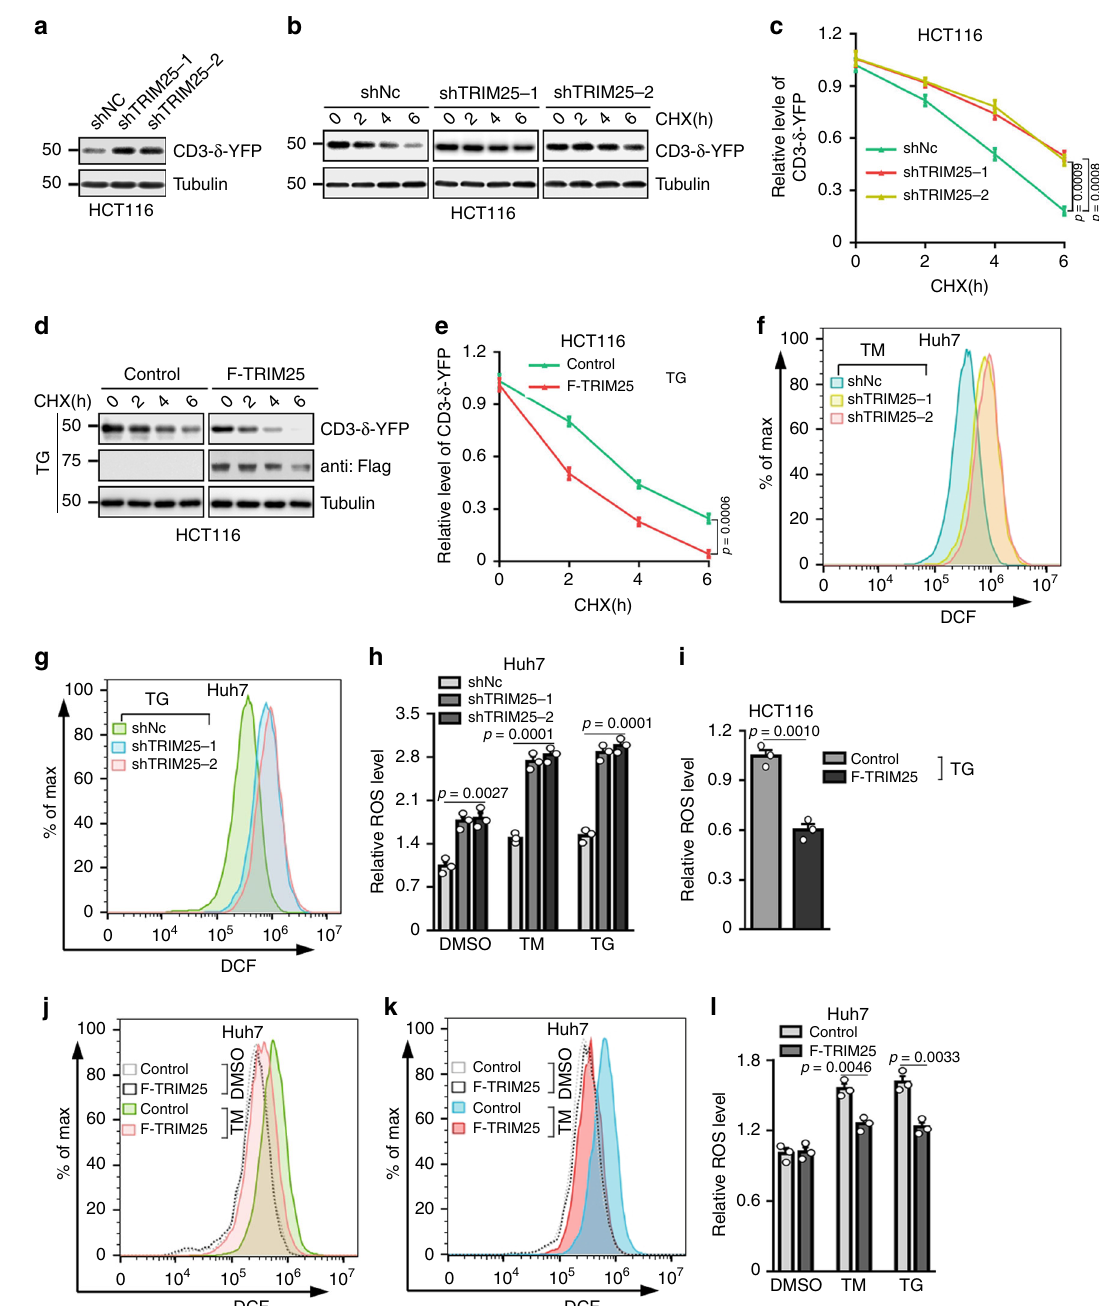
Fig. 2 TRIM25 facilitates ERAD and reduces ER stress induced ROS levels in tumor cells. a Western blot analysis of the levels of CD3- δ -YFP in HCT116 cells with control (shNC) or stable knockdown of TRIM25. b , c Half-life of CD3- δ -YFP in HCT116 cells with control or stable knockdown of TRIM25, treated with cycloheximide (CHX) at the indicated times and analyzed by western blot. Representative western blot ( b ) and quanti fi ed graph ( c ) are shown. In b , the exposures of the corresponding control and TRIM25-knockdown blots were adjusted to achieve comparable levels of CD3- δ -YFP at time 0. d , e Half- life of CD3- δ -YFP in control and F-TRIM25-expressing HCT116 cells pre-treated with TG (1 μ M) for 6 h, then treated with cycloheximide (CHX) at the indicated times and analyzed by western blot. Representative western blot ( d ) and quanti fi ed graph ( e ) are shown. In d , the exposures of the corresponding control and F-TRIM25-expressing blots were adjusted to achieve comparable levels of CD3- δ -YFP at time 0. f – h Flow cytometry analysis of ROS levels in control and F-TRIM25-expressing Huh7 cells treated with TM (5 μ g/ml) ( f ) or TG (1 μ M) ( g ) for 6 h, and quanti fi ed data is shown as ( h ). i Relative ROS levels in control and F-TRIM25-expressing HCT116 cells treated with TG (1 μ M) for 6 h. j – l Flow cytometry analysis of ROS levels in Huh7 cells for control and stable knockdown of TRIM25 treated with TM (5 μ g/ml) ( j ) or TG (1 μ M) ( k ) for 6 h, quanti fi ed data is shown as ( l ). For c , e , h , i and l , data represent the mean ± SEM ( n = 3). Statistical signi fi cance was assessed using two-tailed Student ’ s t